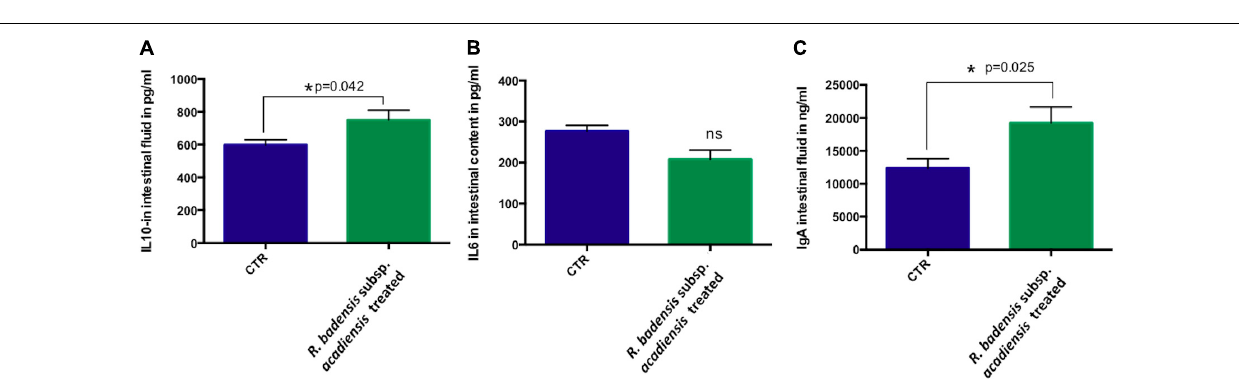
FIGURE 8 | Data represents mean ± SEM of concentration of different (A) anti-inflammatory cytokines IL-10, (B) pro-inflammatory cytokine-IL-6 as well a (C) IgA in the intestinal fluid of (CTR) control mice fed 1% sucrose or R. badensis subsp. acadiensis treated group 10 8 CFU/mouse/day of R. badensis subsp. acadiensis for 7 days. Number of animals per group is n = 10. Difference is considered significant between groups if * p < 0.05 ns = non-significant difference when p >